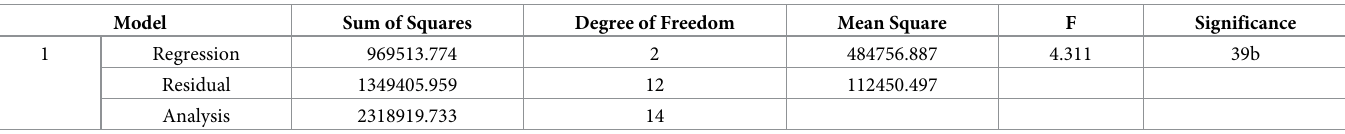
Table 8. Analysis of